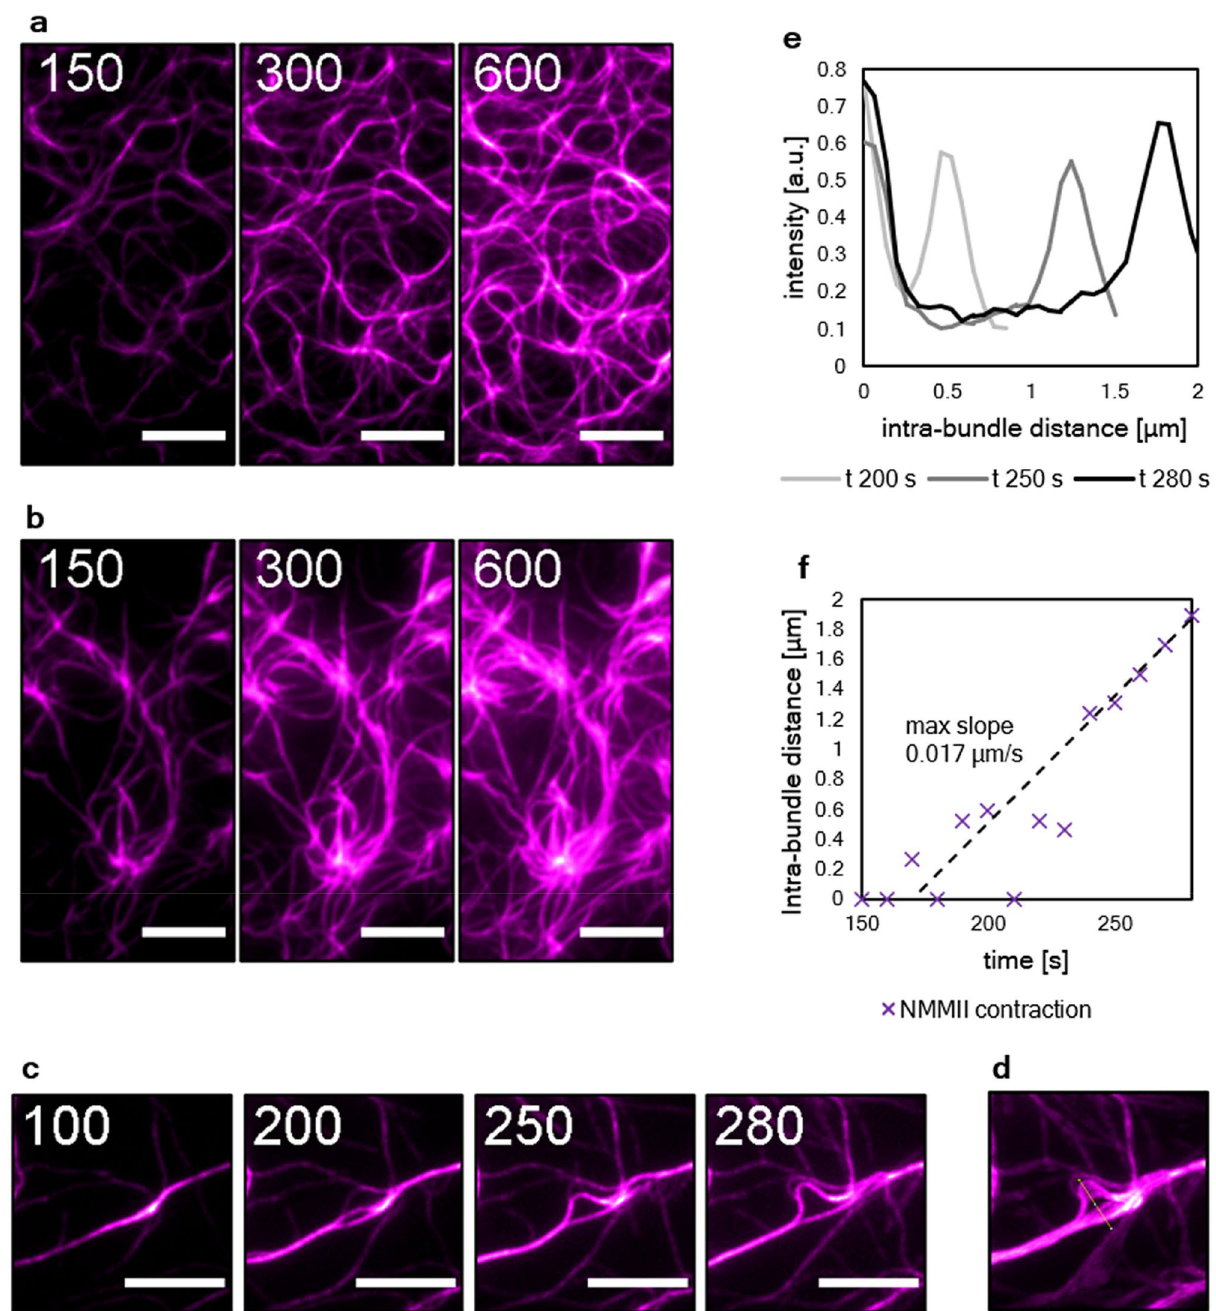
Figure 3. The rearrangement of VASP/actin networks by NMMII is caused by intra-bundle contractions. ( a) Time resolved TIRF imaging of actin network (magenta) polymerization on VASP functionalized supported lipid bilayers in the absence of additional actin-binding proteins. ( b) Polymerization in the presence NMMII. In both cases, time frames at 150 s, 300 s and 600 s after the start of the experiment are shown. The elongation of filaments along preexisting filaments within the bundles can be observed, effectively leading to wider bundles over time with VASP alone, while in the presence of NMMII the fluctuation of bundles and also the emergence of clusters could be observed. Scale bars = 10 µm. ( c) Magnification to visualize the activity of NMMII. Intra-bundle contractions leading to bundle fluctuation and splitting of bundles occurred only in the presence of NMMII. Here, time frames at 100 s, 200 s, 250 s and 280 s are shown. Scale bars = 2 µm. ( d) Intensity projection of every frame between 100 and 300 s at a frame rate of 10 s. A line (yellow) was drawn to evaluate the intensity profiles of the two bundles over time. ( e) Intensity profiles at 200 s, 250 s and 280 s after the start of the experiment representing the previously shown yellow line. The data were normalized to the first peak which represents the lower of the two split bundles. ( f) The distance between the two intensity peaks over time is shown and represent the distance of the split bundles. The distance fluctuated initially since the bundles joined and split multiple times but after about 250 s the bundles began to split with a linear velocity. The slope was determined for the five last time frames to calculate the speed of contraction (0.017